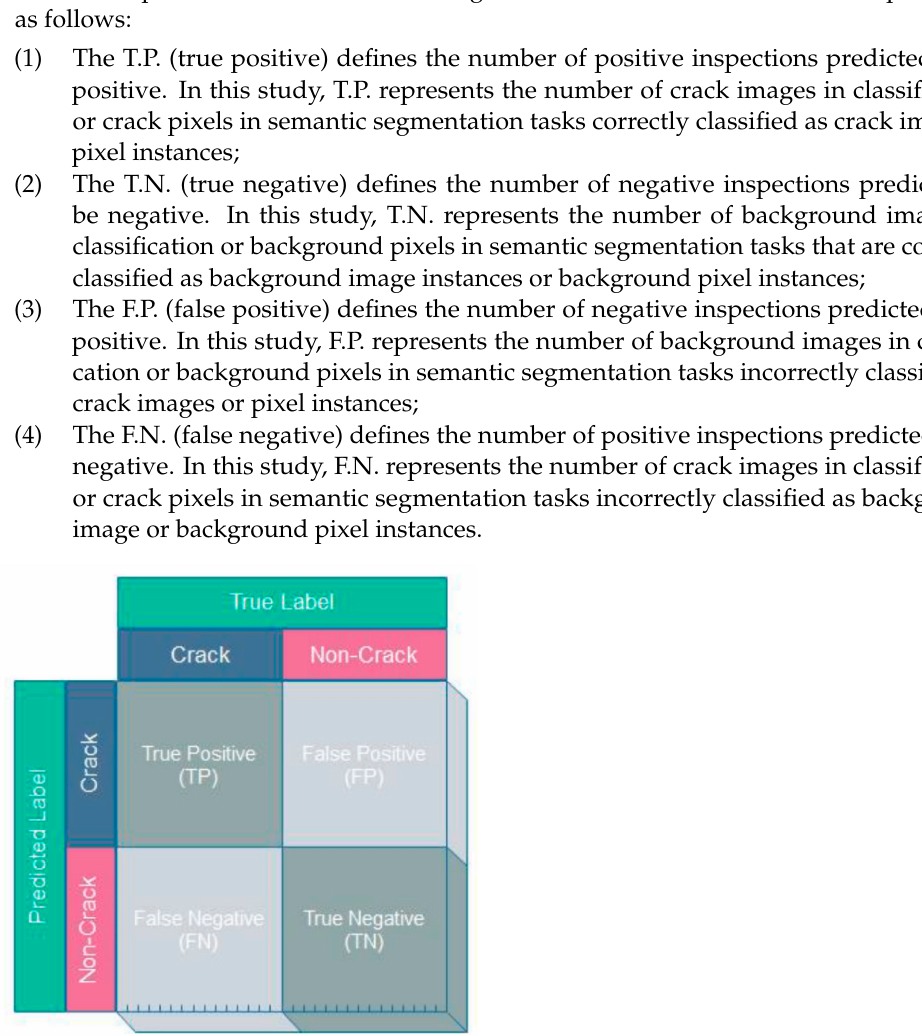
Figure 8. Confusion matrix of crack and